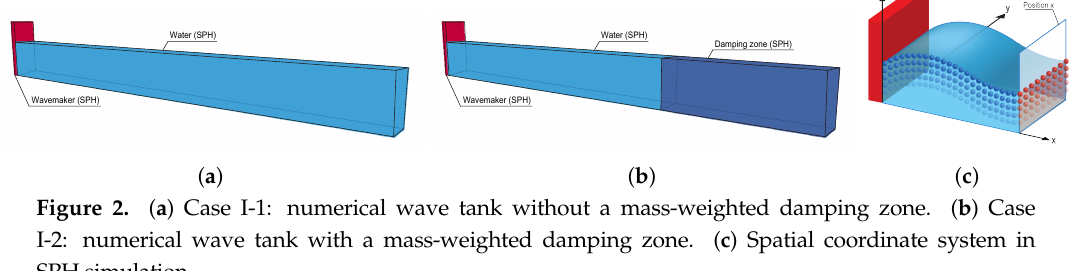
Figure 2. ( a ) Case I-1: numerical wave tank without a mass-weighted damping zone. ( b ) Case I-2: numerical wave tank with a mass-weighted damping zone. ( c ) Spatial coordinate system in SPH